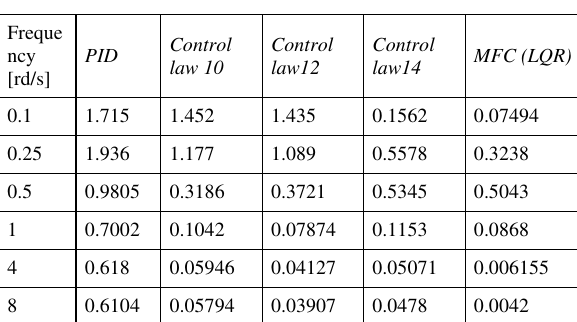
Fig 8e. Influence of turbulences with the use of model- following control (LQR controller) Table 2. Values of performance